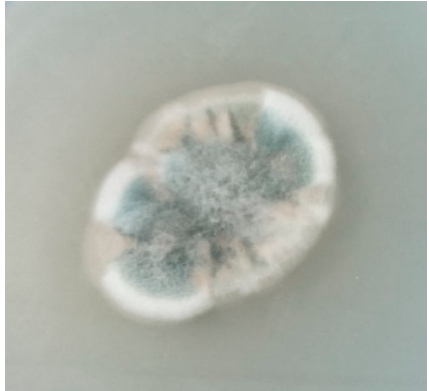
Figure 1. Aspergillus sp. strain WU 243, agar colony on PDA (PD agar) medium after 7 days of incubation at 24 °C.